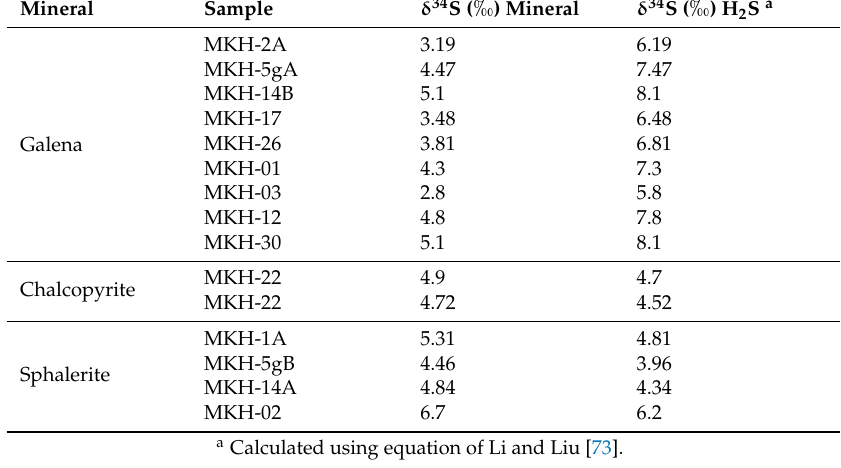
Table 7. Sulfur isotope data for galena, chalcopyrite, sphalerite and H 2 S of the Shah-Ali-Beiglou deposit. The isotopic compositions were calculated using the mean value of the Th of L-V inclusion data obtained from Table 6.